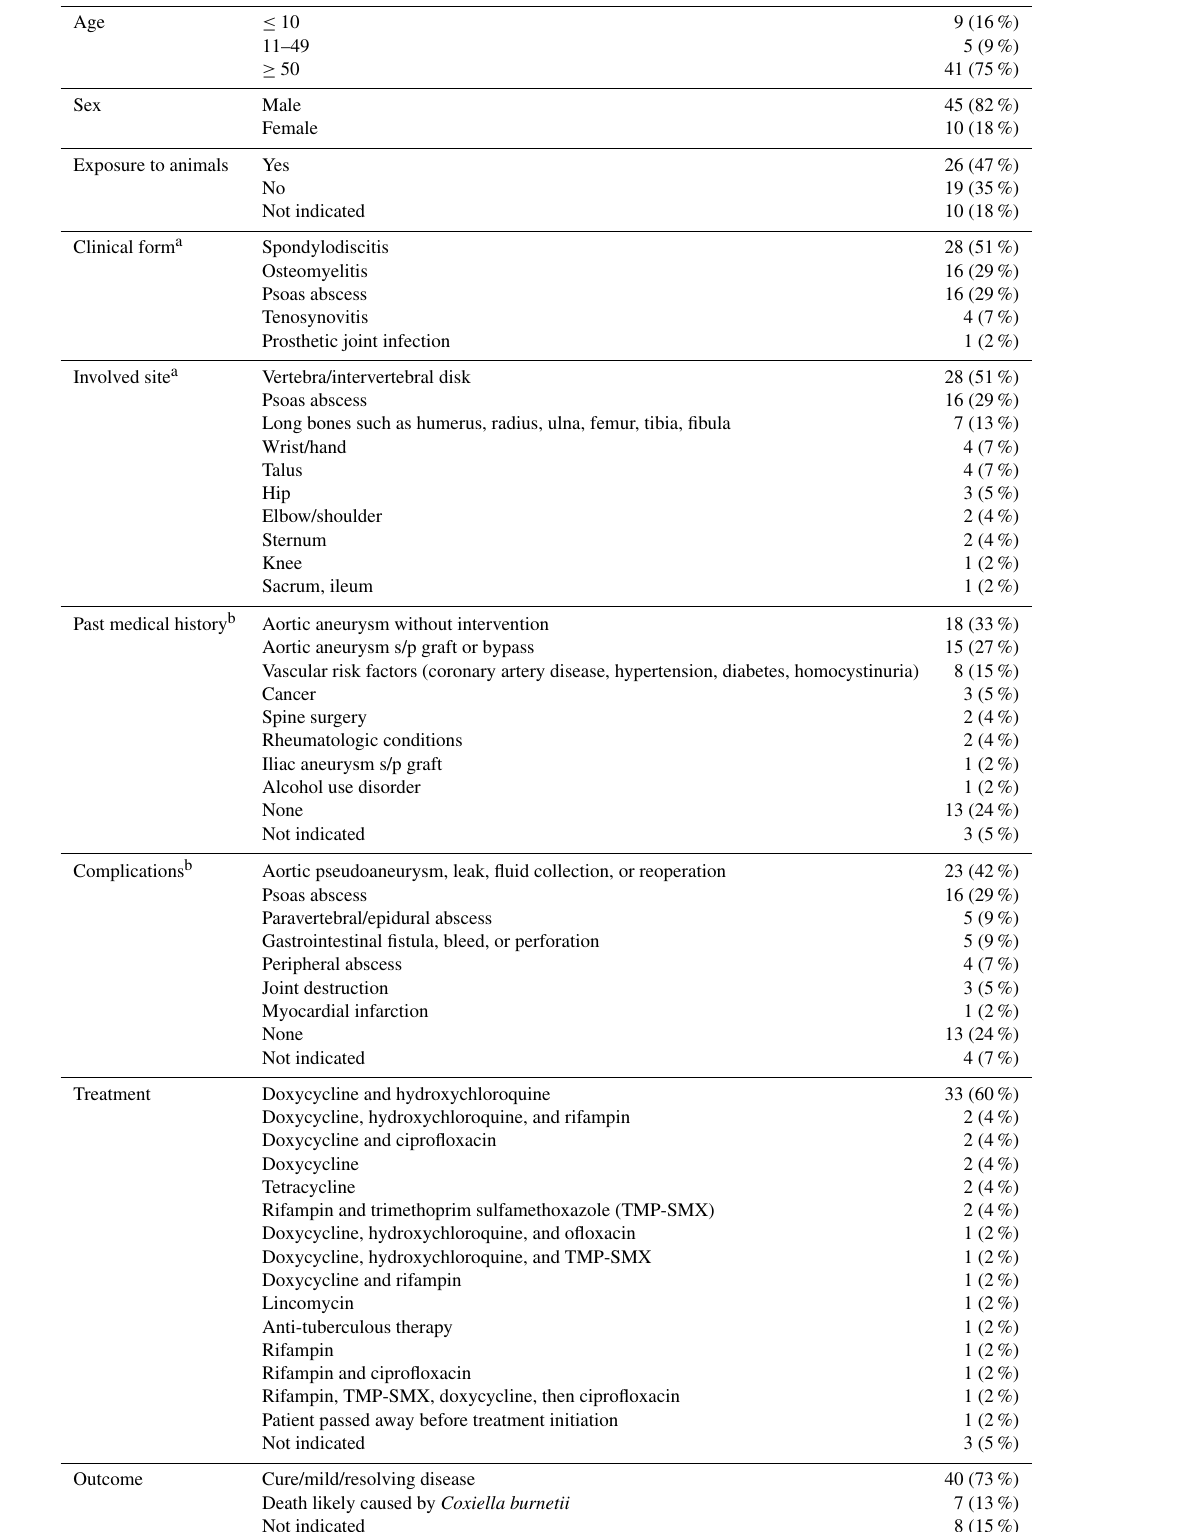
Table 1. Reported cases of Coxiella burnetii with osteoarticular